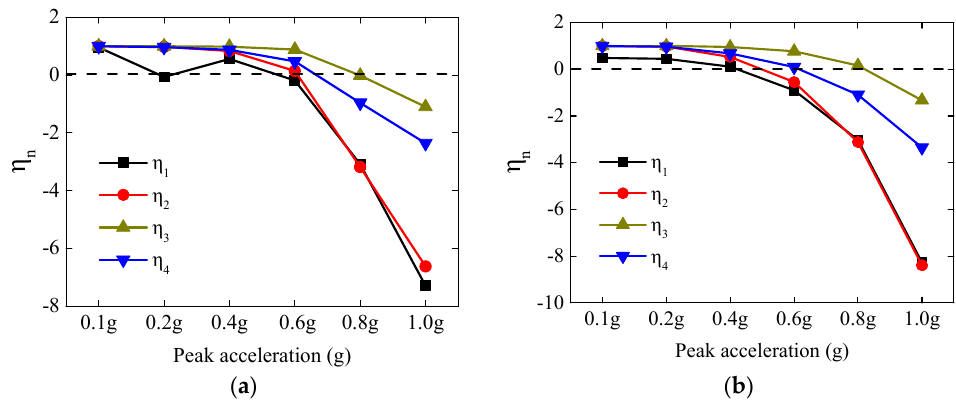
Figure 11. Under the yield acceleration obtained by the Muni method [16] under the El wave and η n value.